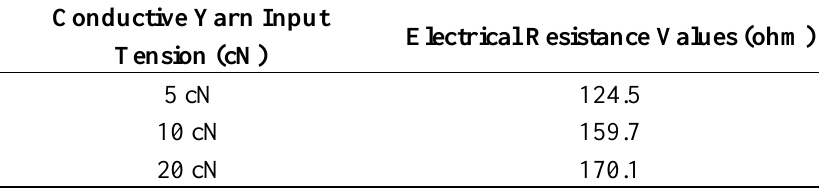
Table 6. Electrical resistance values of samples prior to extension.